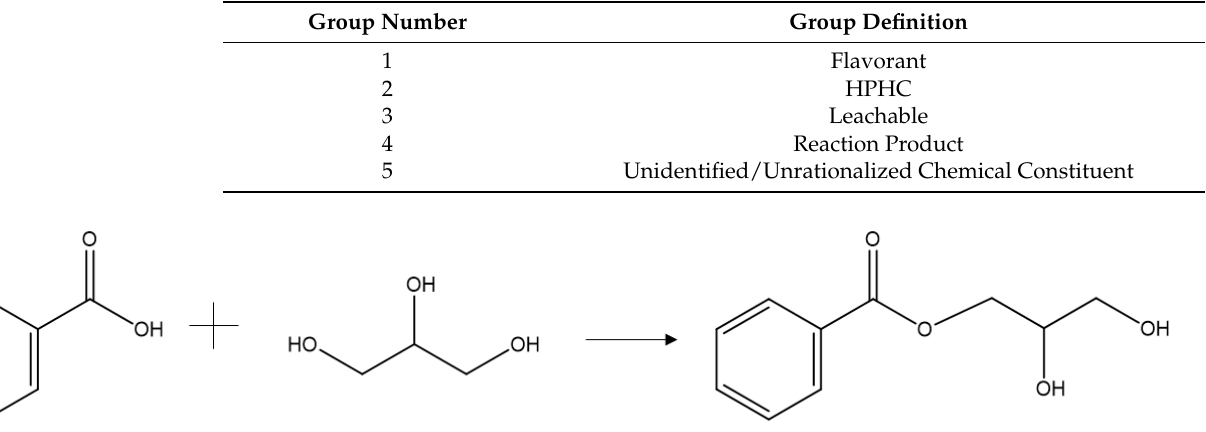
Figure 2. Example of proposed chemical pathway rationalizing the formation of a reaction product, 2,3-dihydroxypropyl benzoate.